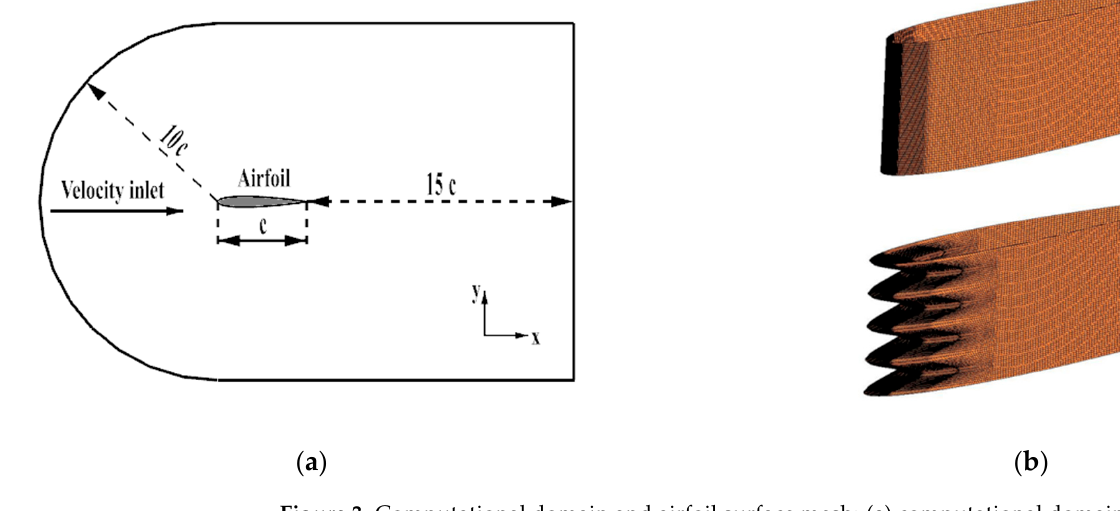
Figure 3. Computational domain and airfoil surface mesh: ( a ) computational domain; ( b ) computa- tional mesh. Table 1. Grid numbers and the independence